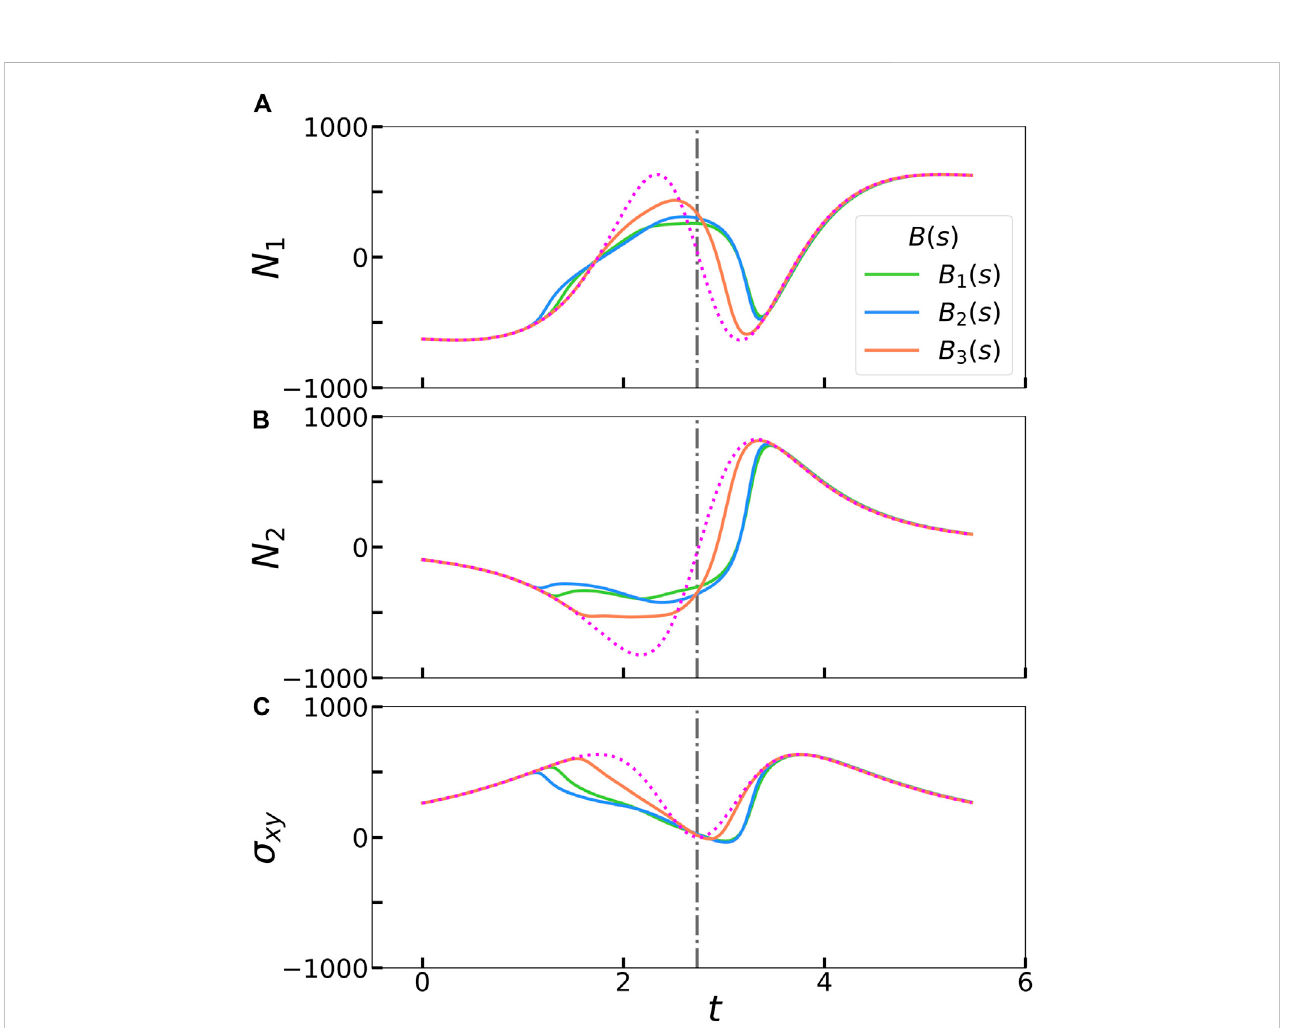
FIGURE 4 Calculated partcle extra stress contributions for the three different rigidity pro fi les during from Figure 2: (A) First normal stress difference N 1 , (B) second normal stress difference N 1 , and (C) shear stress σ xy . The magenta dotted line in each panel represents an unperturbed fi lament that rotates as a rigid rod. The gray dash-dot vertical line represents the time at which a rigid rod is oriented at θ = π /2 relative to the